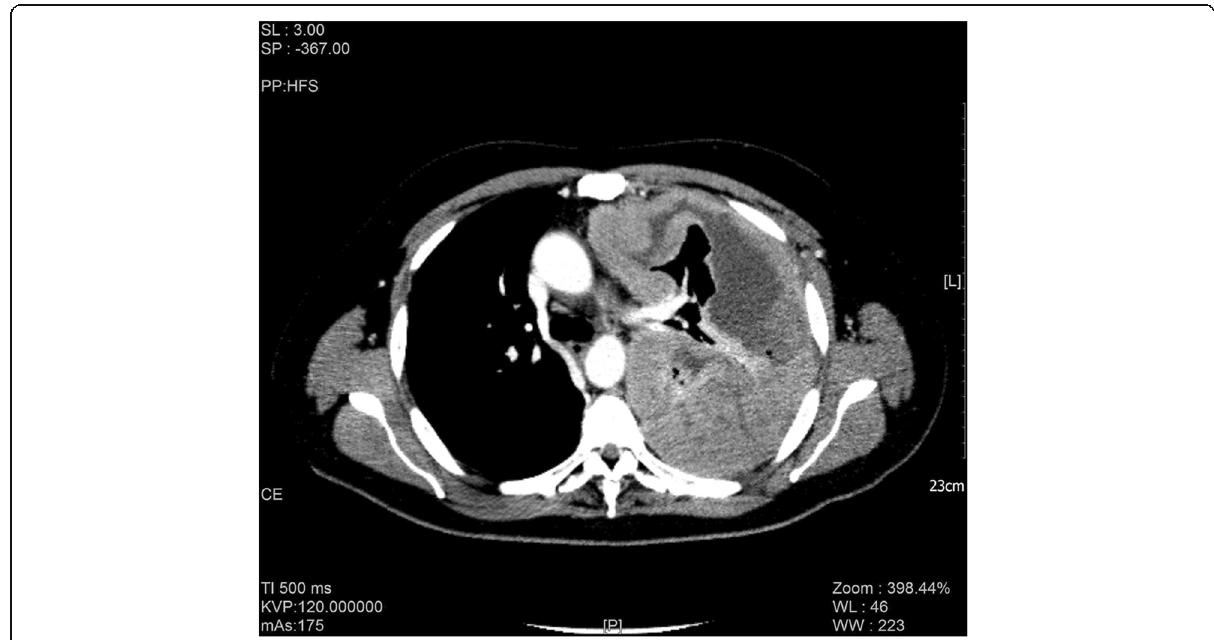
Fig. 1 CT image revealed irregular circumferential pleural thickening with nodular soft tissue masses, involving the mediastinal and diaphragmatic pleura, and extending into the fissures, with reduction of right lung volume